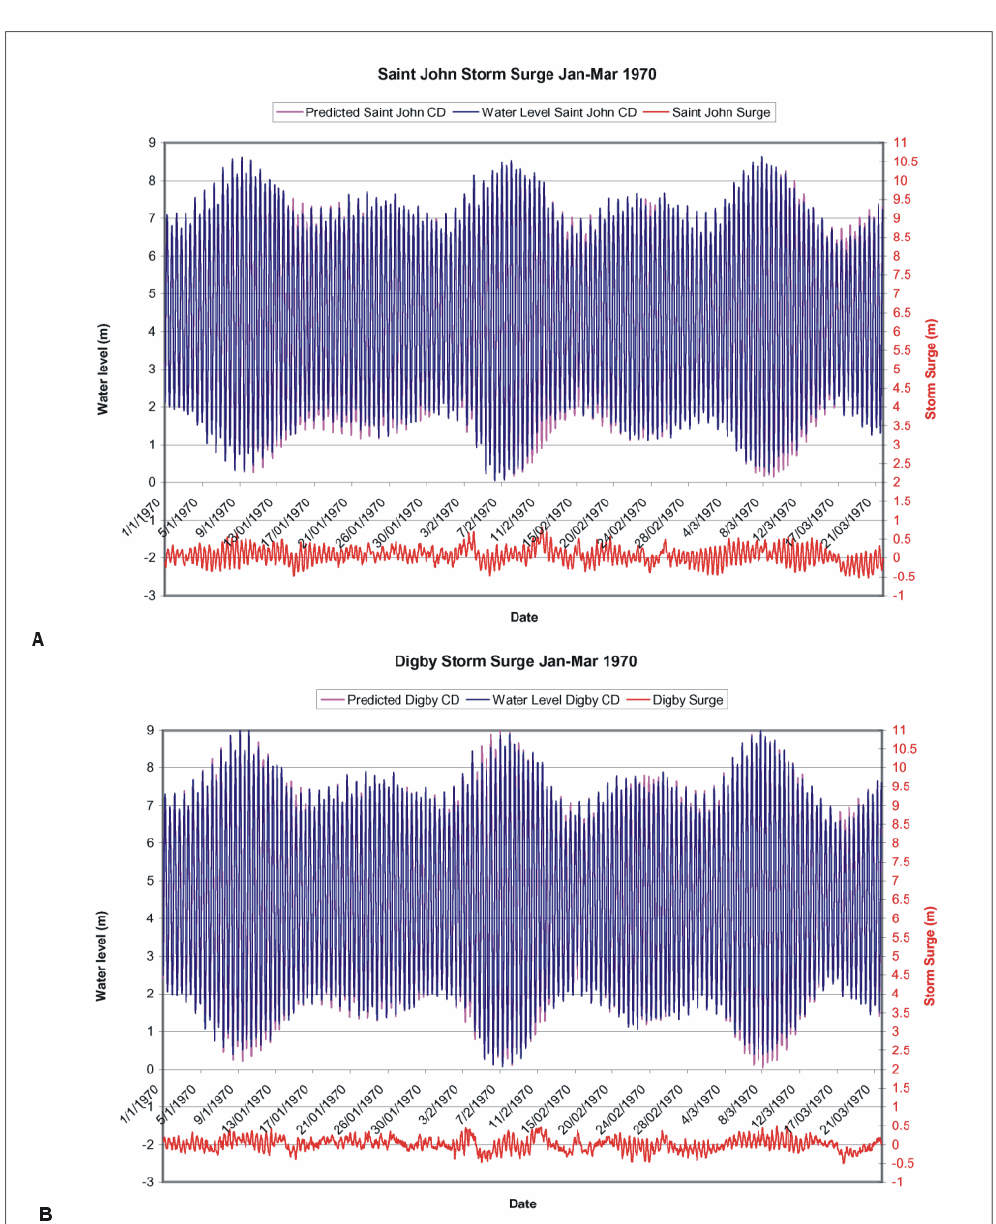
Figure 5. Comparison of water levels at Saint John and Digby for the period of January to March, 1970. Top panel: the observed and predicted water level and calculated storm surge (m) for Saint John, NB. Middle panel: the observed and predicted water level and calculated storm surge (m) for Digby, NS. Bottom panel: comparison of the storm surges for Saint John (shades of blue) and Digby (shades of red) with a 48 hour mean (heavy lines) to reduce high frequency noise and the difference between them (heavy black